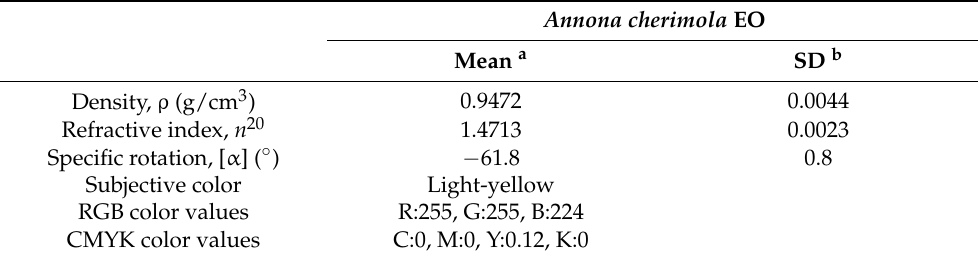
Table 1. Physical properties of the essential oil.